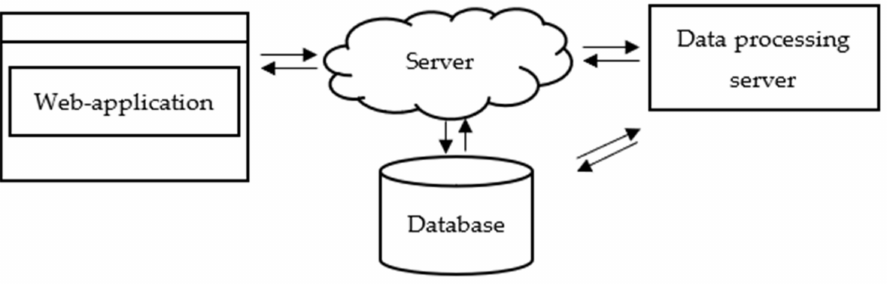
Figure 14. Quality inspection system. Figure 15 illustrate the system flow chart. There are few essential parts: